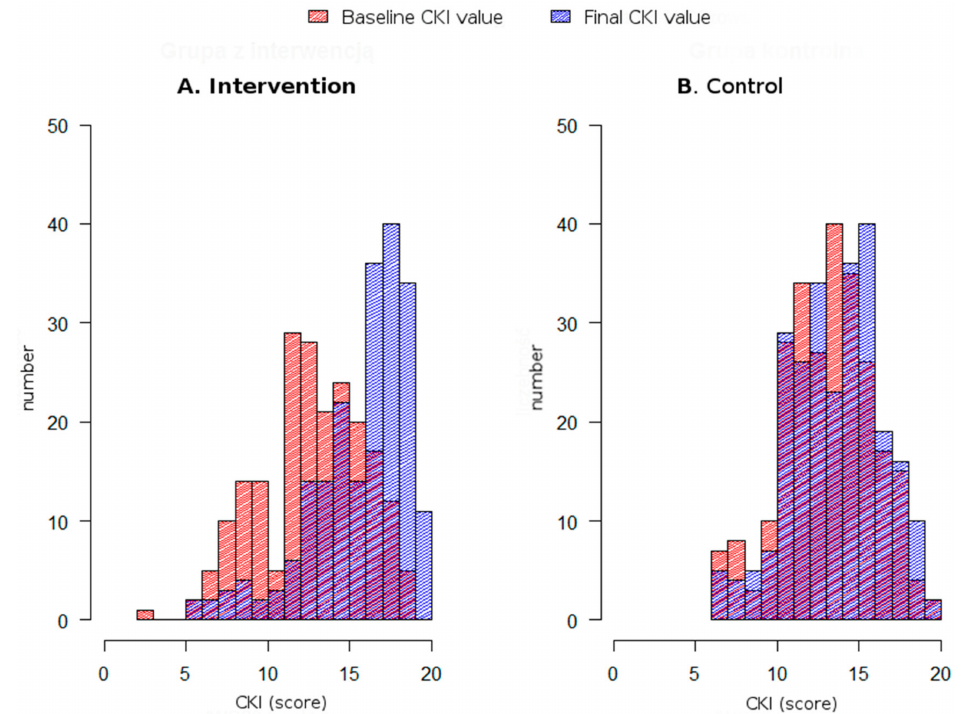
Figure 2. CKI scores before (grey) and after (black) educational intervention in the interventional ( A ) and control ( B )